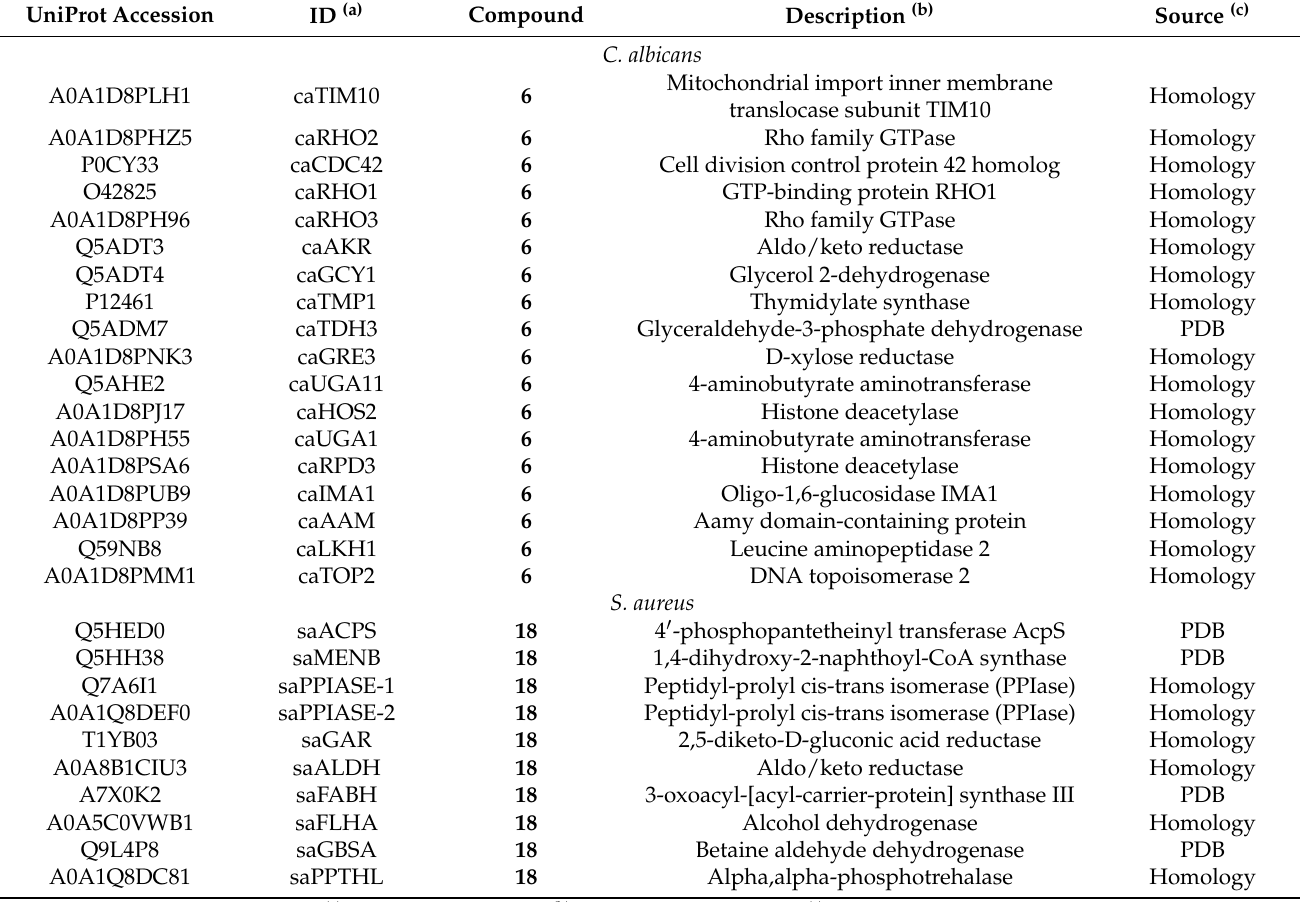
Table 9. Predicted targets of compounds 6 and 18 in C. albicans and S. aureus